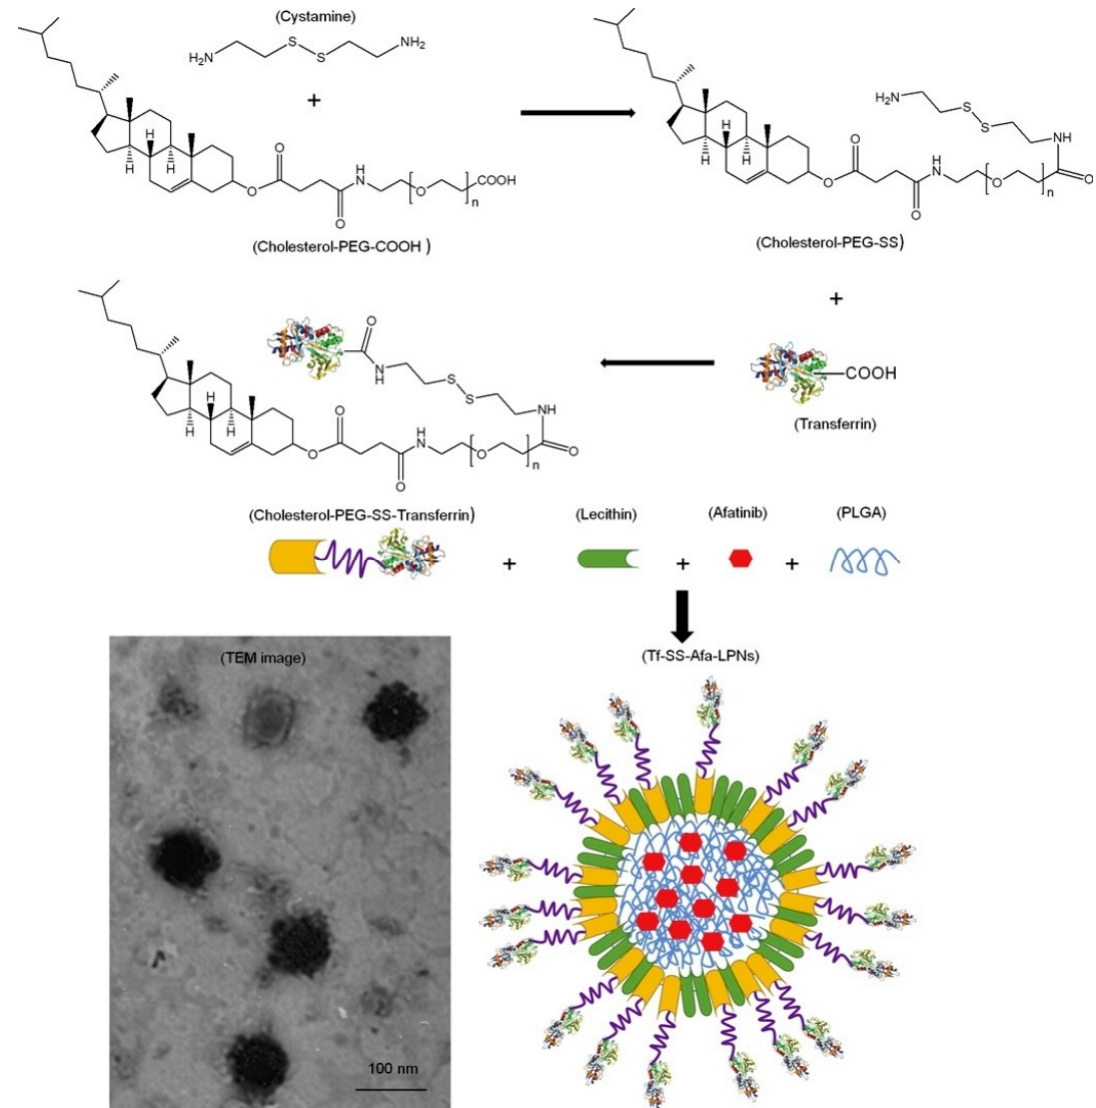
Figure 5. Synthesis of Cholesterol-PEG-SS-Transferrin and the transmission electron microscopy (TEM) image of afatinib-loaded cho-PEG-ss-Tf PLHNPs. The particle was synthesized by conjugating cholesterol-PEG and transferrin with cysteamine via amide bond formation, followed by afatinib (a tyrokinase inhibitor) loaded into the PLGA core through hydrophobic interactions. Transferrin protein binds to the transferrin receptor at the cell membrane and enhances drug delivery in the tumor cells and resulted in glutathione (GSH) stimuli responsive (disulphide bond breakage in the presence of GSH) drug release. Reprinted with permission from [86], Copyright © 2019 under American Chemical Society.